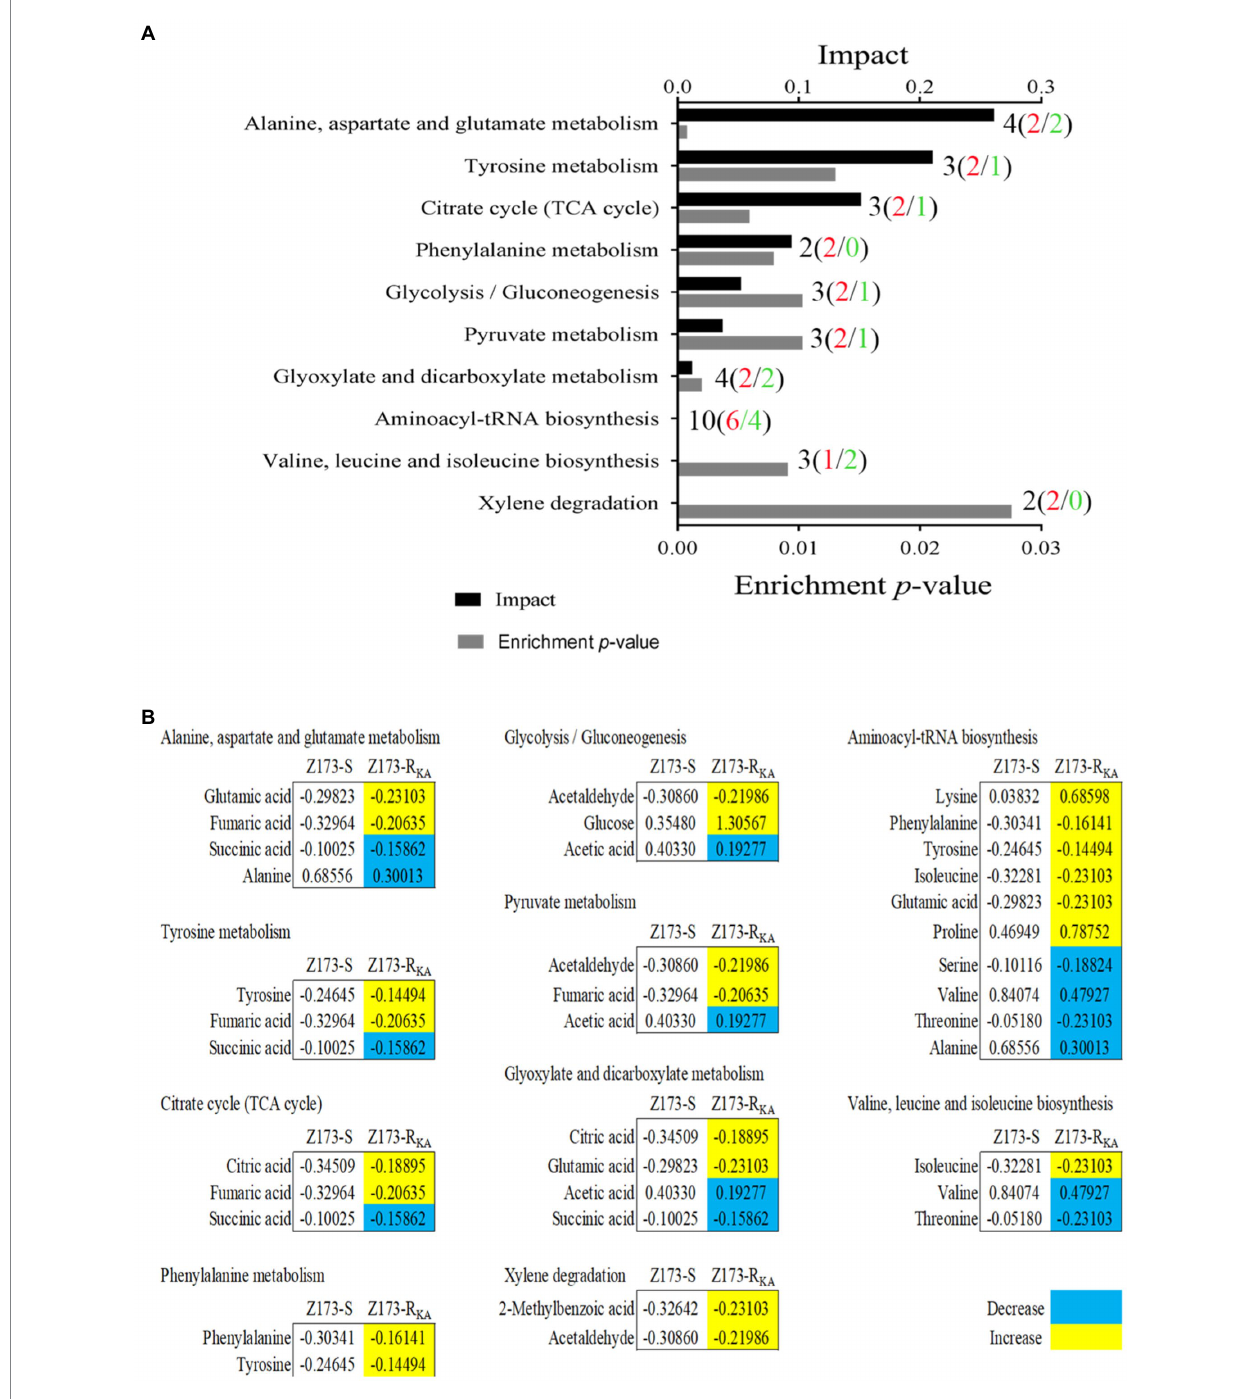
FIGURE 3 Pathway enrichment analysis. (A) Pathways are enriched in differential abundance of metabolites between Z173-S and Z173-R KA . Significantly enriched pathways are selected to plot ( p -value < 0.05), and their impact was indicated. Black, red, and green fonts of the labels refer to the number of the total, upregulated, and downregulated differential metabolites in each metabolic pathway, respectively. (B) The relative abundance of metabolites of each pathway listed in (A) . Numbers show the relative values of differential metabolites. Yellow color and blue color indicate increased and decreased metabolites,